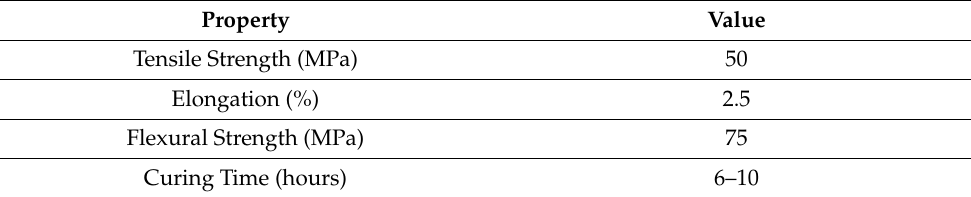
Table 3. Properties of